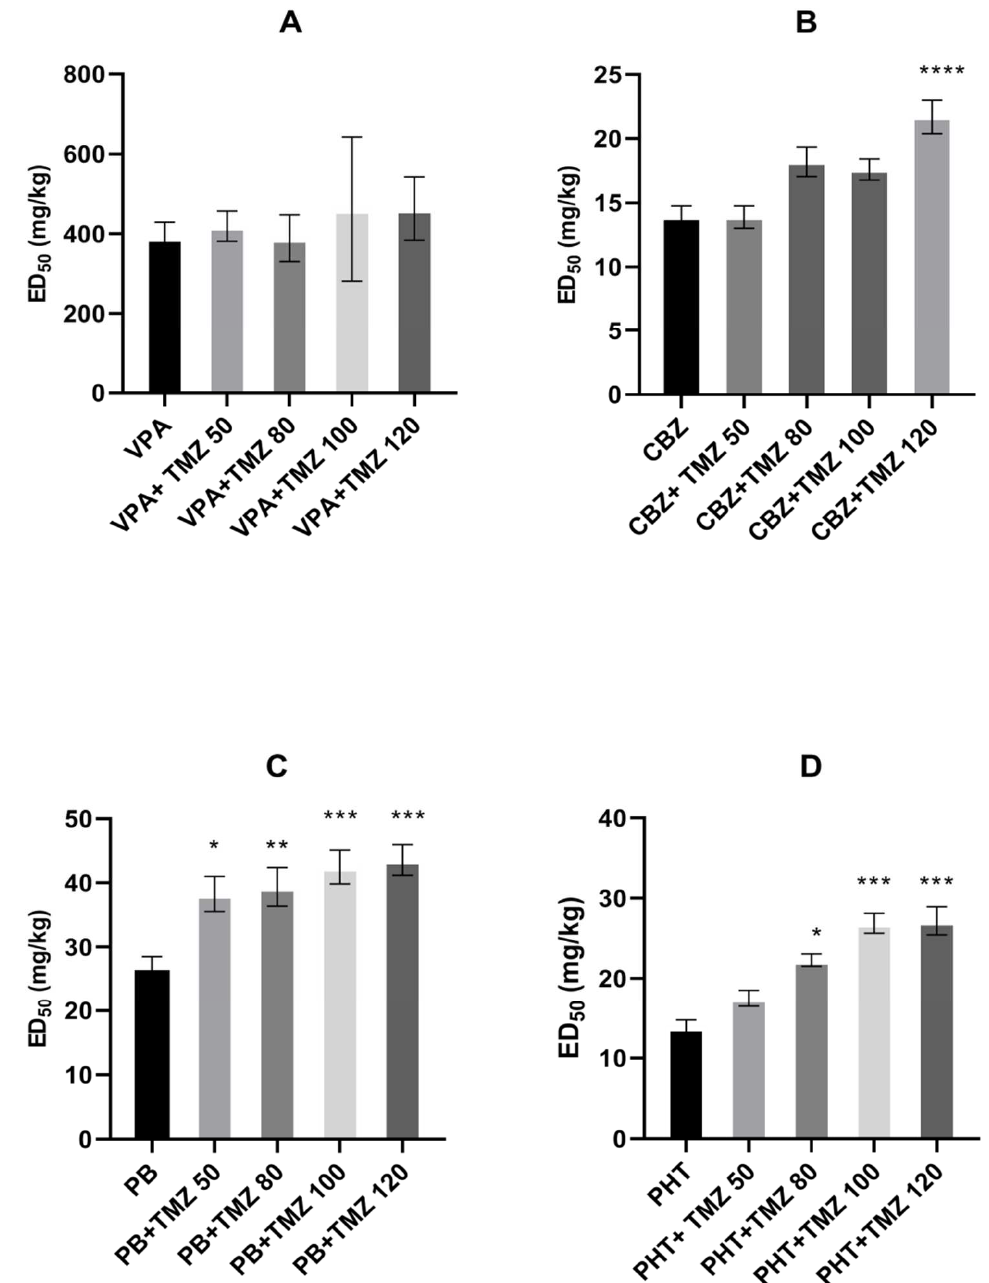
Figure 1. Effect of trimetazidine (TMZ) on the anticonvulsant action of ( A ) valproate (VPA), ( B ) carbamazepine (CBZ), ( C ) phenobarbital (PB), and ( D ) phenytoin (PHT) against maximal electro- shock-induced seizures in mice. Data are presented as median effective doses (ED 50 in mg/kg) with standard errors (SEM) that protect 50% of animals from the tonic-clonic seizures. Statistical analysis of the data was performed using one-way analysis of variance (ANOVA) followed by a post hoc Tukey test. * p < 0.05, ** p < 0.01, *** p < 0.001, **** p < 0.0001 vs. control group.